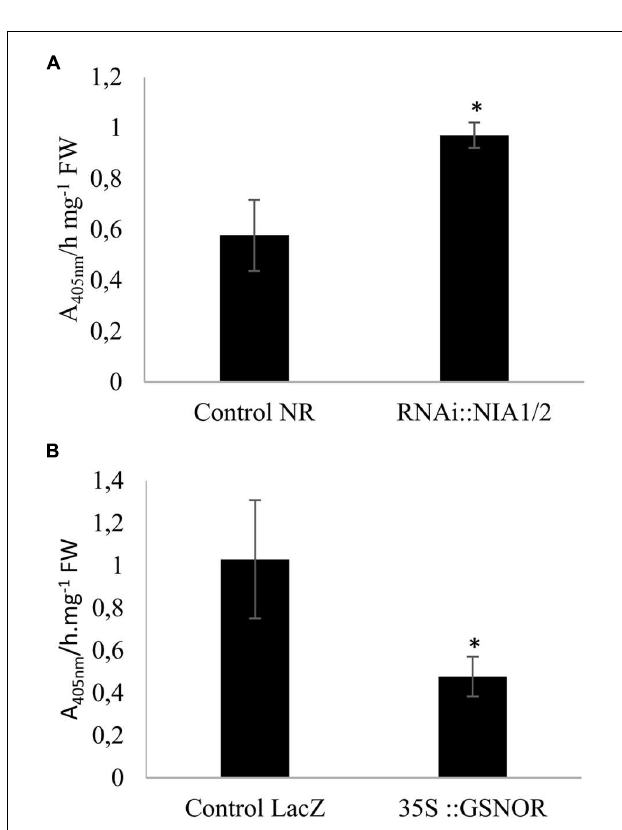
FIGURE 2 | Quantification of Aphanomyces euteiches in extracts from inoculated transformed roots. RNAi::NIA1/2 -transformed roots (A) and 35S::GSNOR -transformed roots (B) were extracted for ELISA tests. Roots were cultivated in vitro for 7 days on Fahraeus medium and then inoculated with A. euteiches . The background signal in non-inoculated roots was subtracted from the signal detected in inoculated roots. Error bars indicate standard errors ( n = 4), and ∗ indicates significant differences ( p < 0.05). Data from one representative experiment out of four independent